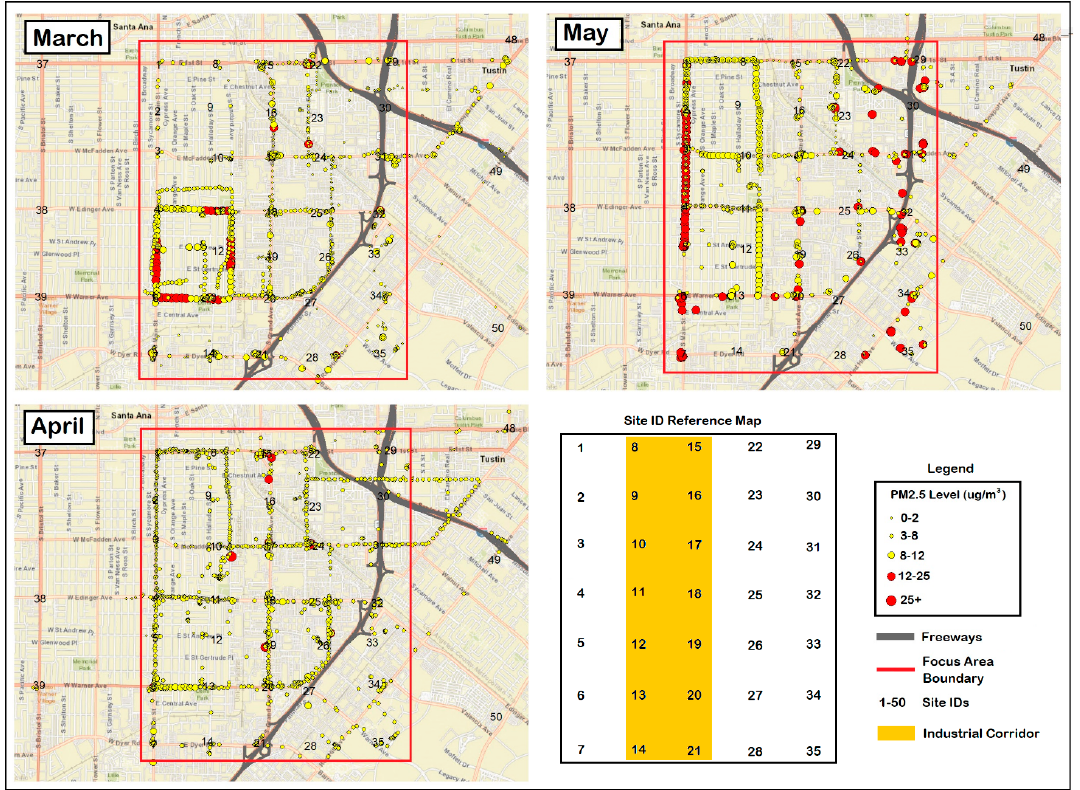
Figure 4. One-minute average PM 2.5 measurements projected across the Focus Area in Santa Ana using high-resolution GPS tracking devices. Red dots denote PM 2.5 > 12 μ g/m 3 . using high-resolution GPS tracking devices. Red dots denote PM 2.5 > 12 µ g/m 3